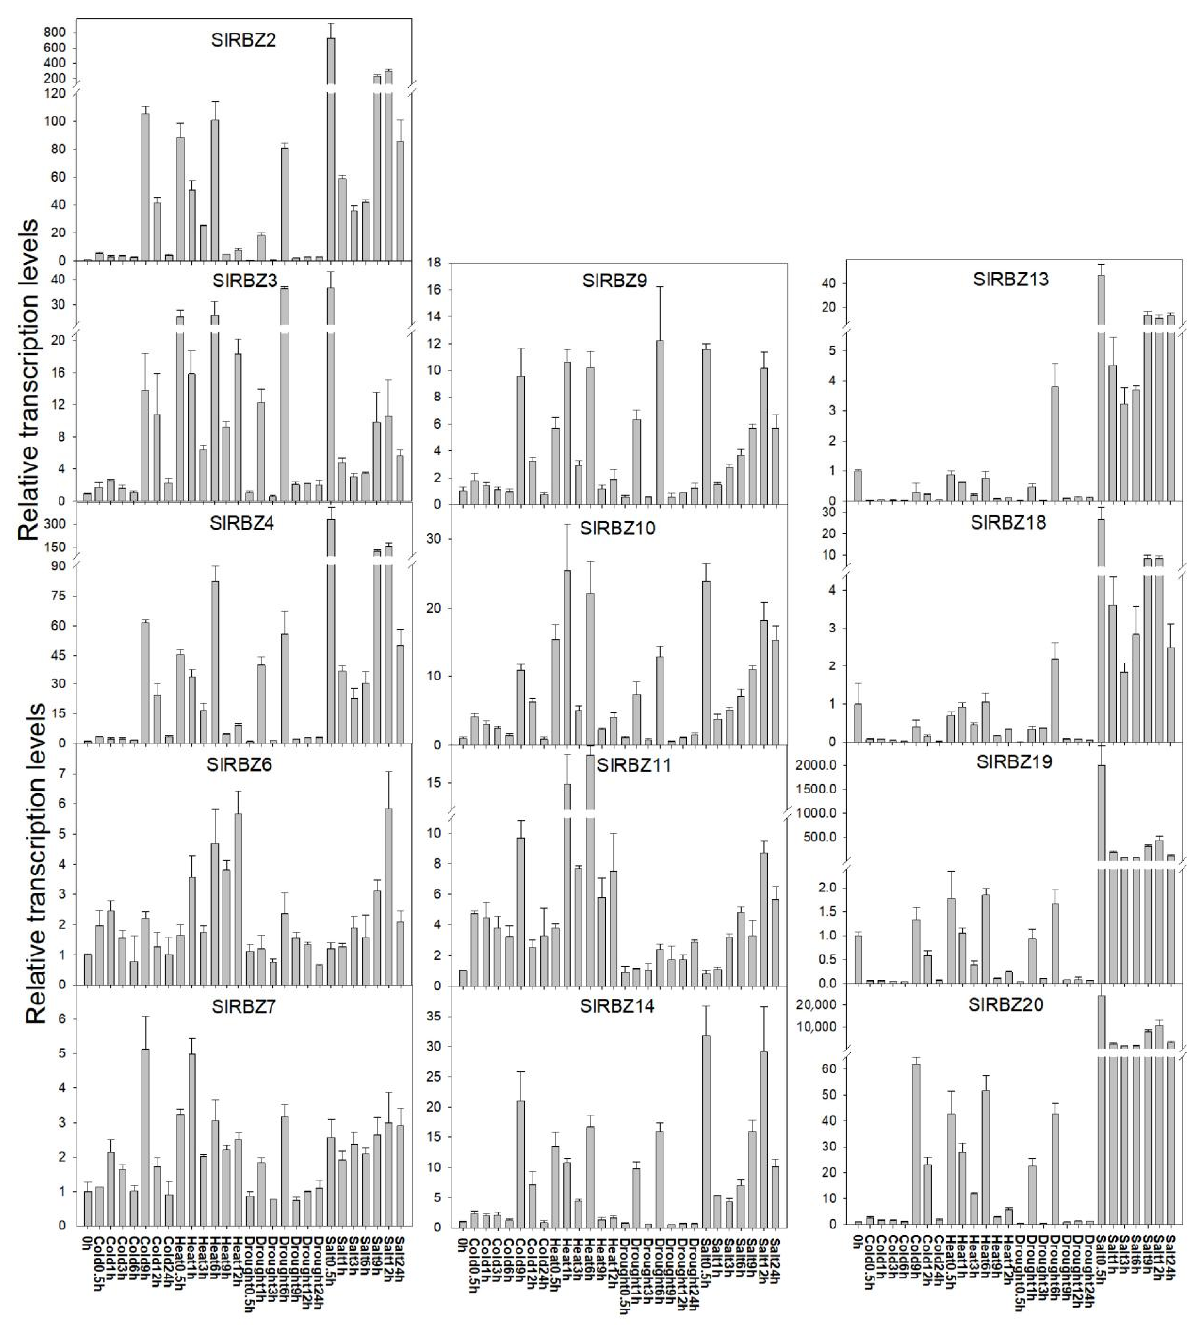
Figure 9. Expression patterns of SlRBZ genes under abiotic stresses by qRT-PCR. Error bars represent standard deviations for the three replicates.